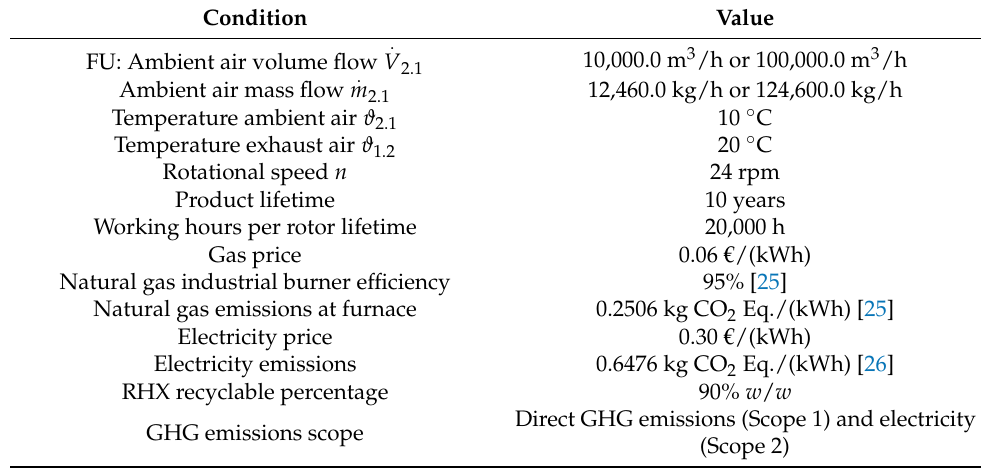
Table 1. Economic and ecological